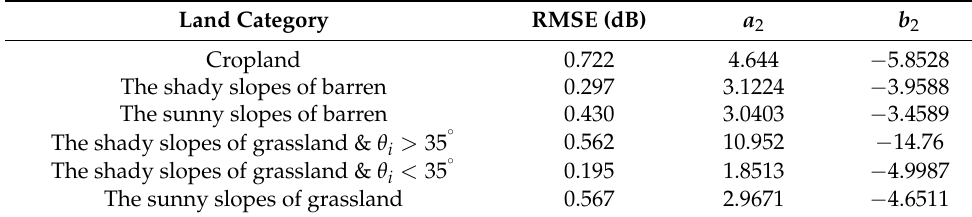
Table 4. Comparison of function fitting accuracy and parameters.